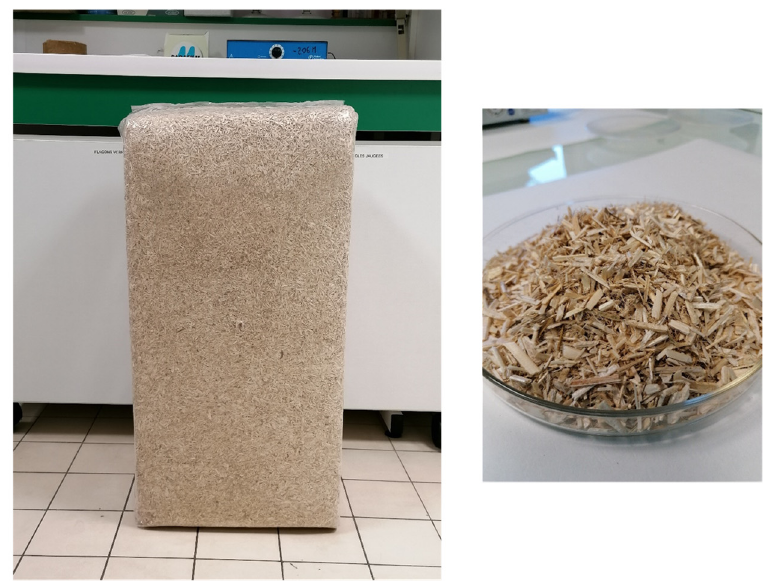
Figure 1. Ch è nevotte or hemp shives from a French agricultural cooperative (Eurochanvre, Figure 1. Chènevotte or hemp shives from a French agricultural cooperative (Eurochanvre, Arc- Arc-les-Gray, France). les-Gray, France).